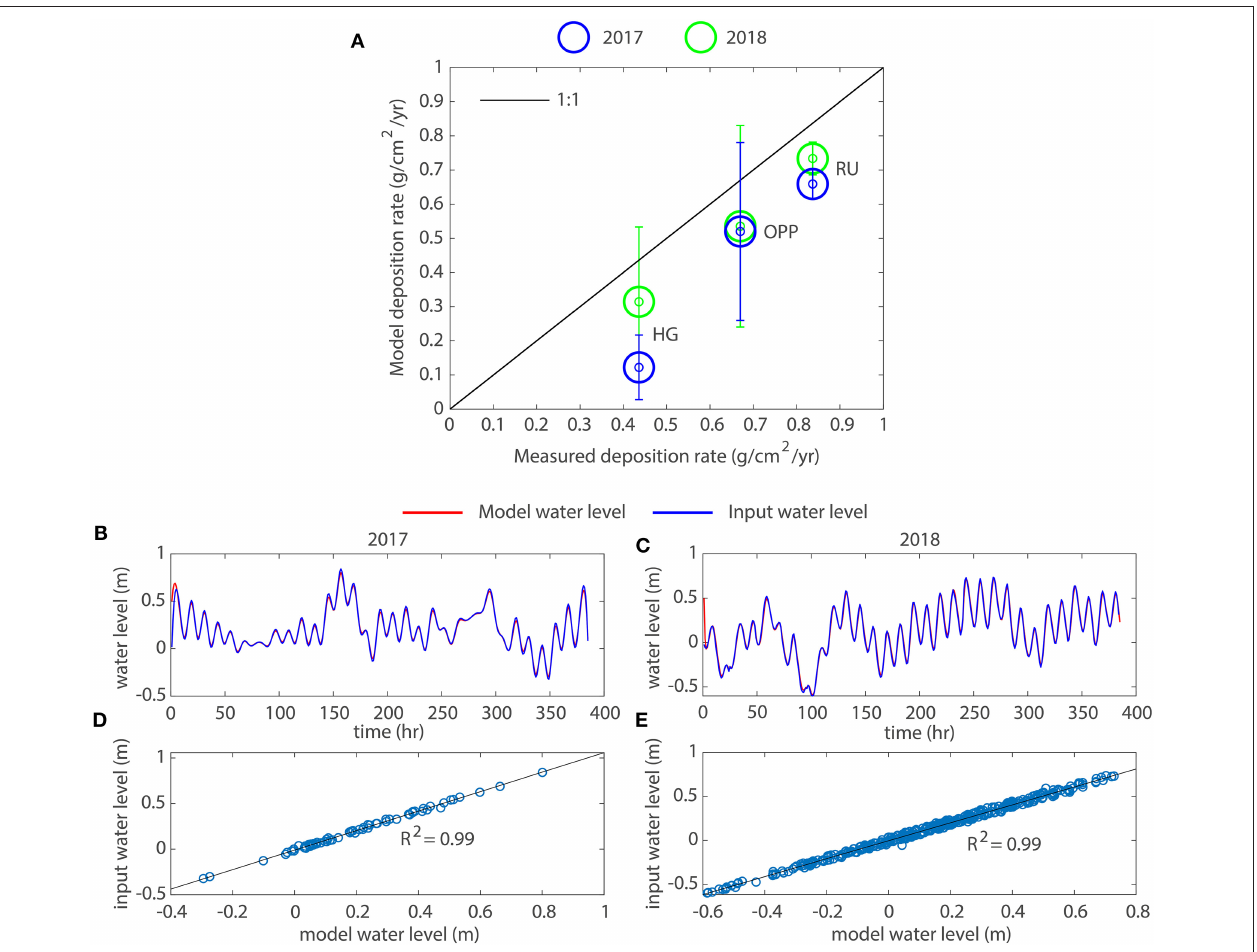
FIGURE 5 | (A) Deposition rate validation obtained from the model. Error bars refer to above and below an SD. (B,D) Water level validation for the year 2017. (C,E) Water level validation for the year 2018.